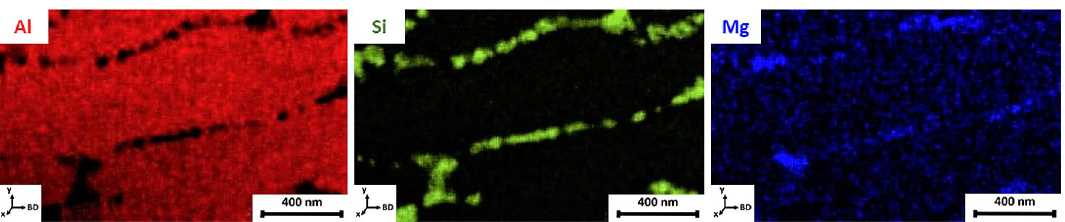
Figure 8. STEM-EDX mappings (Al, Si, Mg) representing a primary Al cell recorded at the MPC in the as-built LPBF-processed AlSi 10 Mg 0.3